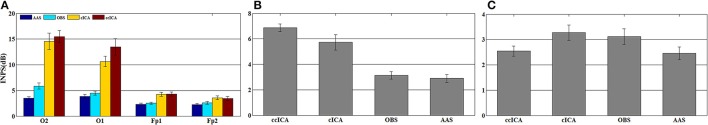
Mean INPS over the 10 subjects. (A) Mean INPS over the 10 subjects of different electrodes from 8 to 12 Hz. (B) Mean INPS over the 10 subjects of all electrodes from 8 to 12 Hz. (C) Mean INPS over the 10 subjects of all electrodes from 1 to 5 Hz.